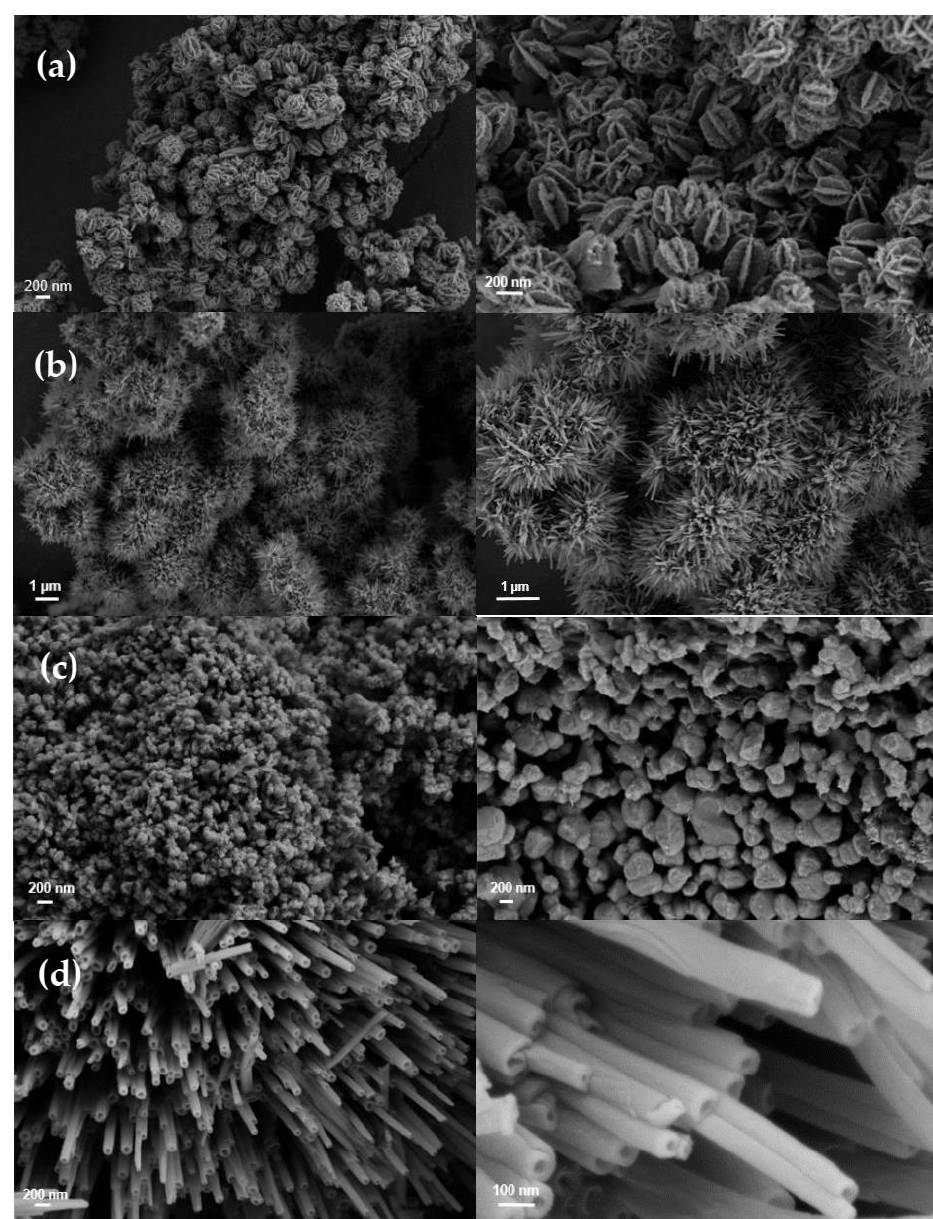
Figure 1. SEM images of various VO 2 nanoparticles: ( a ) asterisk-shaped ( b ) urchin-like, ( c ) multi- faceted spherical ( d ) nanotube. Images on the right column represent the magnified versions of those on the left column.